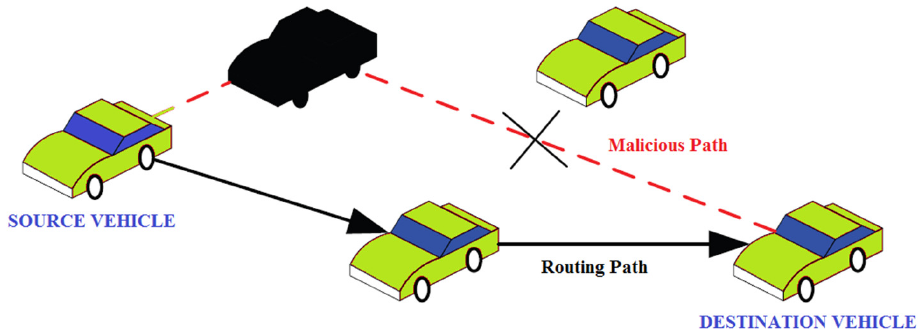
Figure 6. Working of Black hole attack [32].